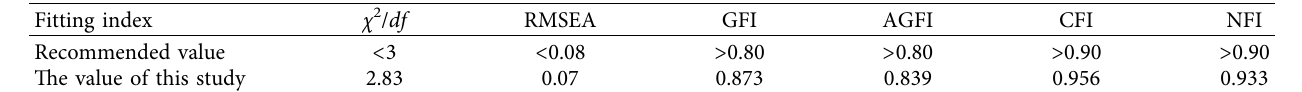
Table 7: Recommended value and actual value of model fitting